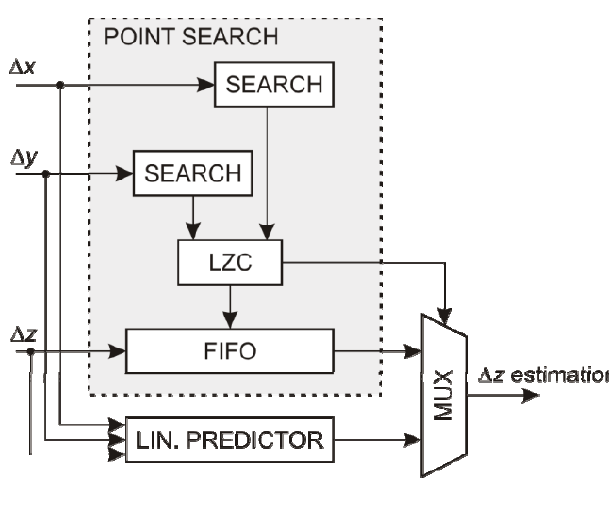
Figure 7. The structure of z -coordinate predictor.